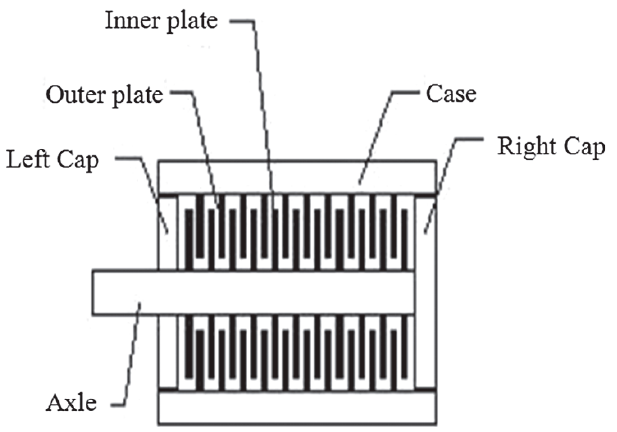
Figure 2. A simplified structure of a VC.